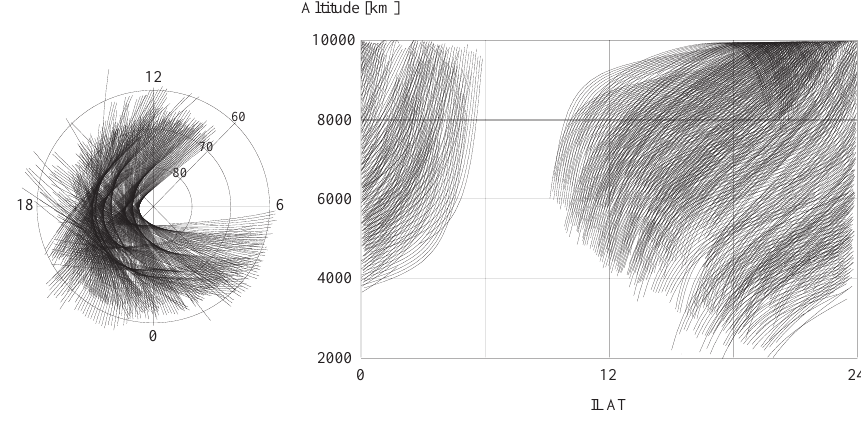
Fig. 5. Plots of the Akebono orbit during December 1989 to February 1990. For most of the time, the Akebono satellite was located at the high altitudes above nightside auroral region.